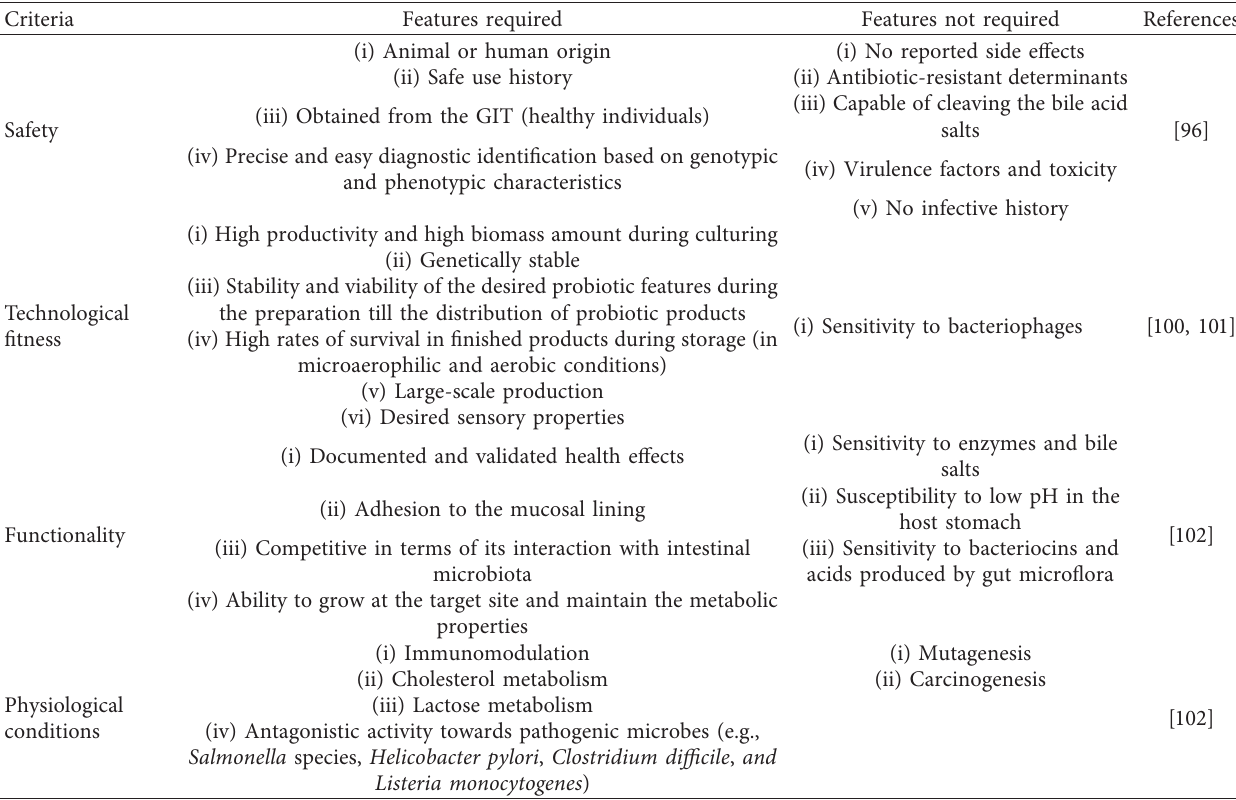
Table 1: Selection criteria of